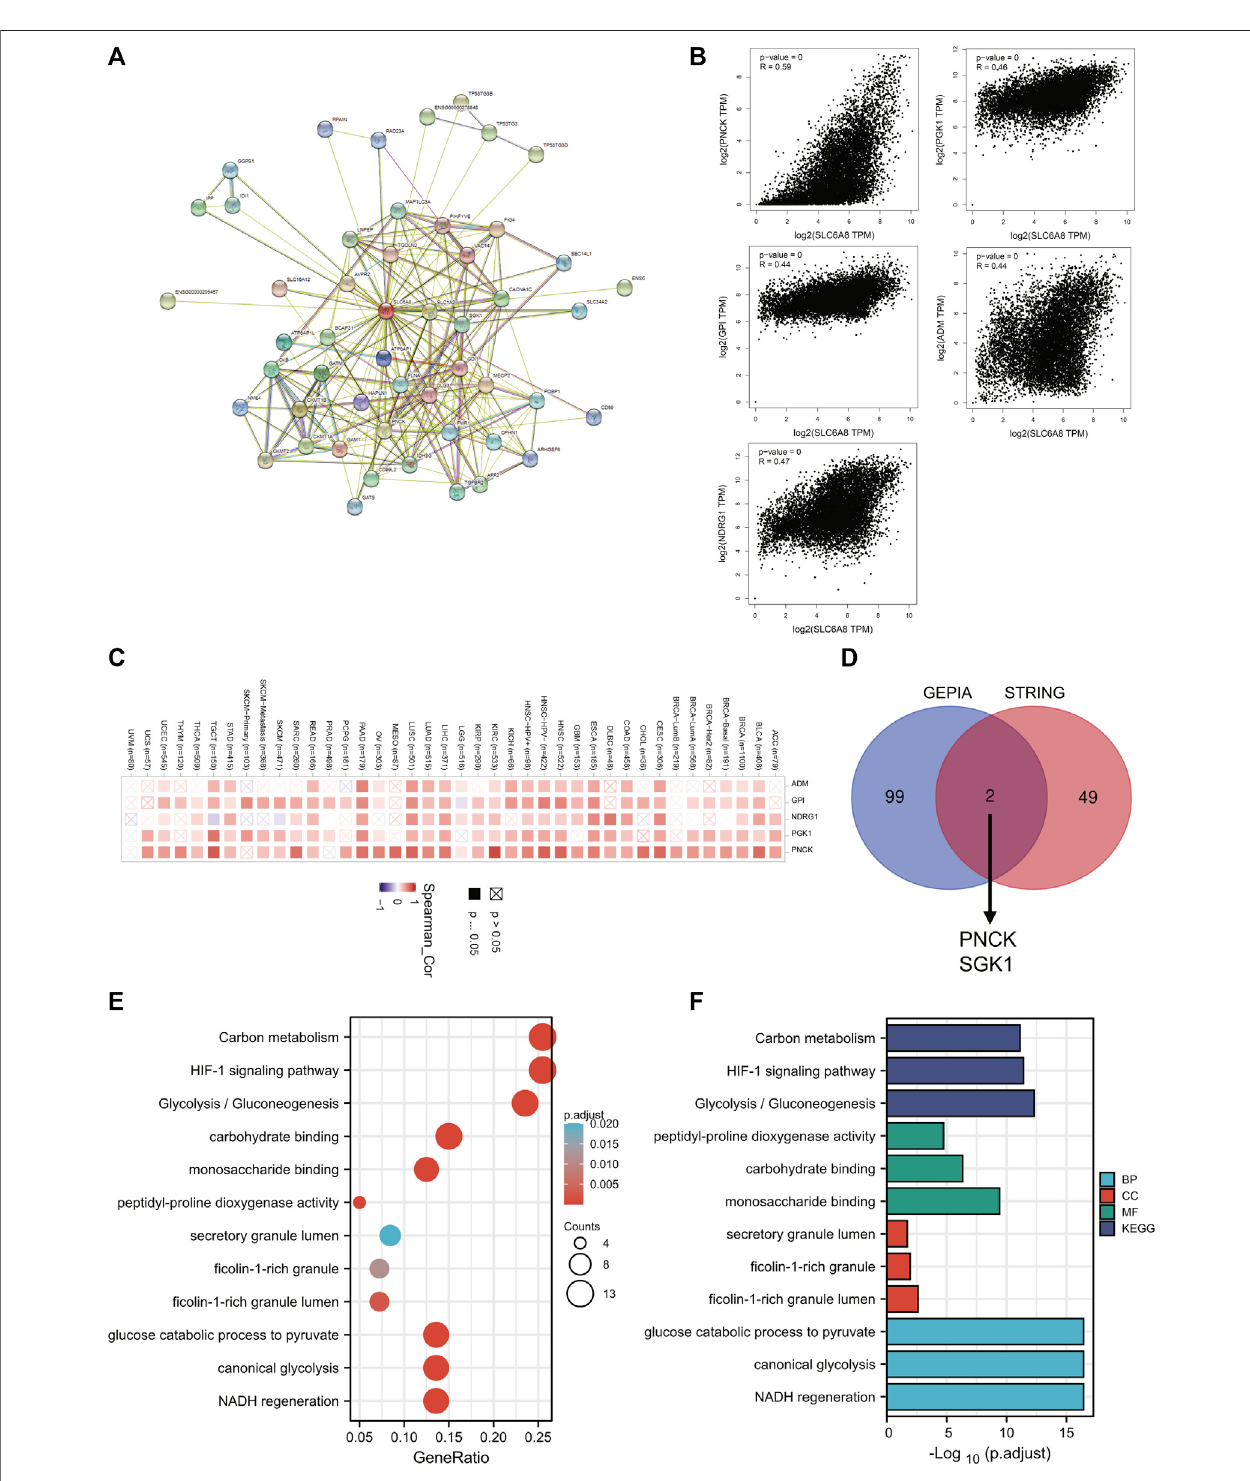
FIGURE 6 | Analysis of pathways enriched for SLC6A8 in cancers. (A) Protein-protein interaction network of SLC6A8 was determined via STRING database. (B) PearsoncorrelationanalysisofSLC6A8expressionanditstop5relatedgenesaccordingtoGEPIA2. (C) Theexpressionsofthe5genesthataremostrelatedto SLC6A8 expressionindetailedcancertypeswereillustratedbytheheatmap. (D) ThevenndiagramshowingthecommonmembersofGEPIA2-basedSLC6A8-associatedgenes and STRING-based SLC6A8-interacting proteins. (E) and (F) KEGG pathway (E) and GO (F) enrichment analysis based on SLC6A8 -related genes (proteins).